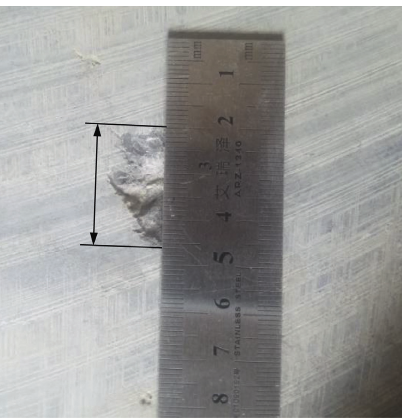
Figure 4: Measurement of the rock breakage